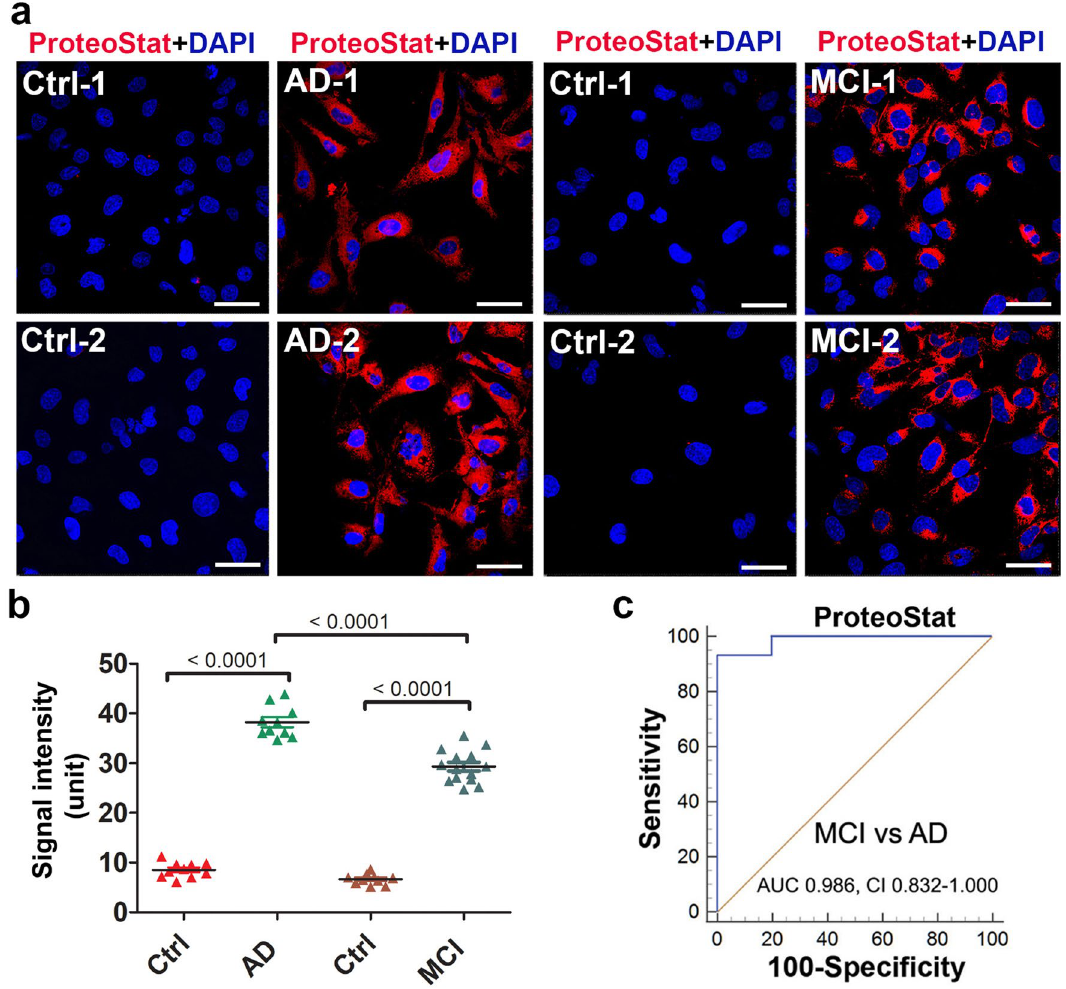
or their corresponding age-matched controls (Ctrl) (n = 10 for AD, n = 9 for MCI), fixed at 24 h and then stained with ProteoStat dye. The nuclei were stained with DAPI (blue). Bar: 50 µm. ( b ) The fluorescence intensity in cells were measured and statistically compared among groups. Data are expressed as mean ± SEM and analyzed by one-way ANOVA. ( c ) ROC analyses show robust difference in ProteoStat signal between the samples from MCI (n = 14) and AD (n = 10)